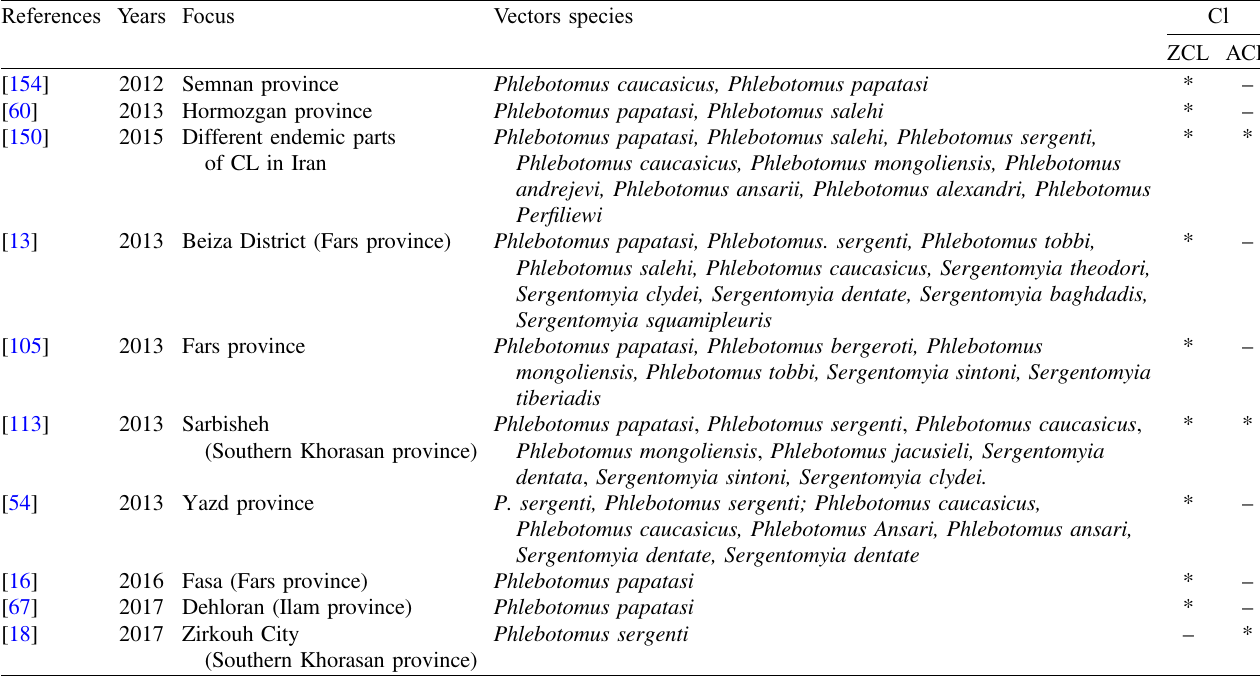
Table 2. Vectors of anthroponotic cutaneous leishmaniasis (ACL) and zoonotic cutaneous leishmaniasis (ZCL) Iran. References Years